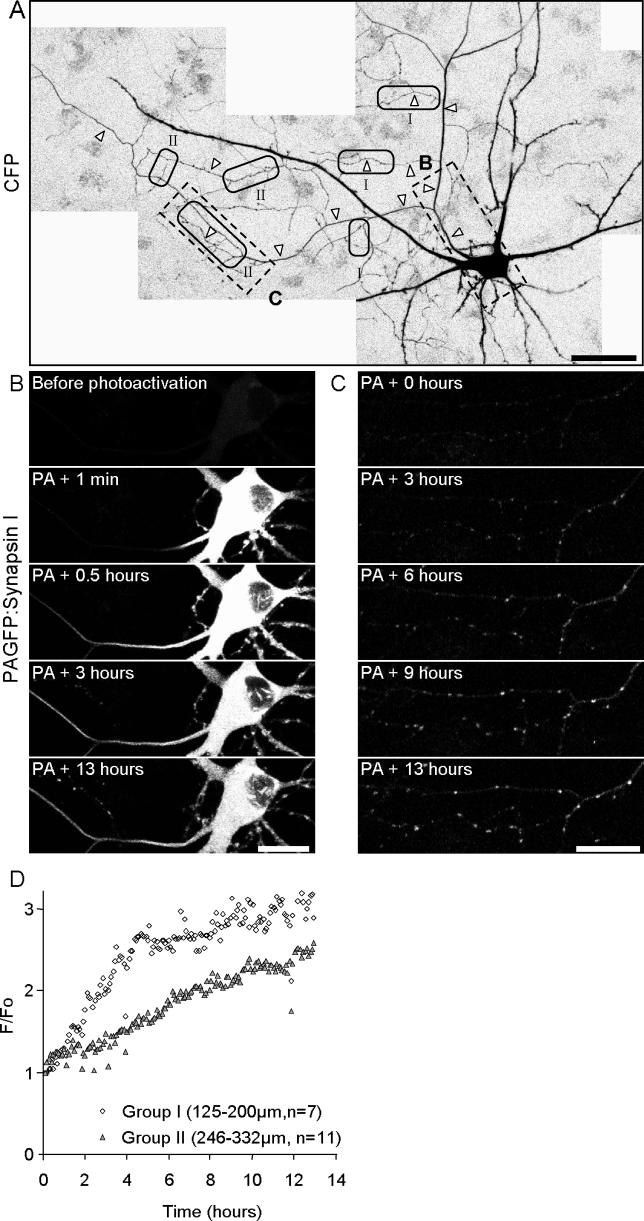
Incorporation Rates of Synapsin I from Somatic Sources at Remote Presynaptic Boutons(A) Low-magnification composite image of a neuron expressing CFP and PA-GFP:Synapsin I. Only CFP fluorescence is shown here. Parts of the axonal arbor are marked with arrowheads. Fluorescence is encoded using an inverted gray scale to increase detail clarity.(B) Higher magnification of rectangle marked as “B” in (A). At time t = 0, PA-GFP:Synapsin I within the cell body was photoactivated by selective illumination of the soma at 405 nm. Within minutes, photoactivated PA-GFP:Synapsin was observed to spread out into the axon and, much later, to appear at presynaptic boutons in the same field of view.(C) Higher magnification of rectangle marked as “C” in (A), enclosing a group of relatively remote presynaptic boutons. Note the gradual increase in fluorescence of these remote boutons over time.(D) Quantification of fluorescence changes at remote boutons following photoactivation of somatic PA-GFP:Synapsin. Boutons were grouped according to distance from the soma as shown in (A). Fluorescence data for each bouton were normalized to prephotoactivation fluorescence levels at the same bouton. Bars: (A), 50 μm; (B and C), 20 μm.